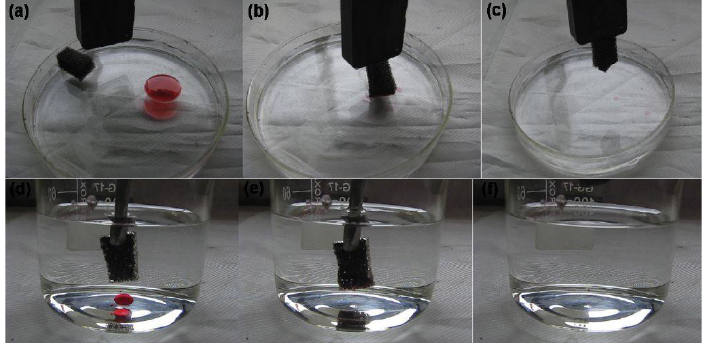
Figure 3. Demonstration images for the removal of hexadecane oil, dyed with red, from the water surface using a piece of foam controlled by a magnet ( a – c ); Reprinted from Colloids and Surfaces A: Physicochemical and Engineering Aspects, Bo Ge, Xiaotao Zhu, Yong Li, Xuehu Men, Peilong Li, Zhaozhu Zhanga, Versatile fabrication of magnetic superhydrophobic foams and application for oil/water separation, Pages No.4 Copyright (2015), with permission from Elsevier